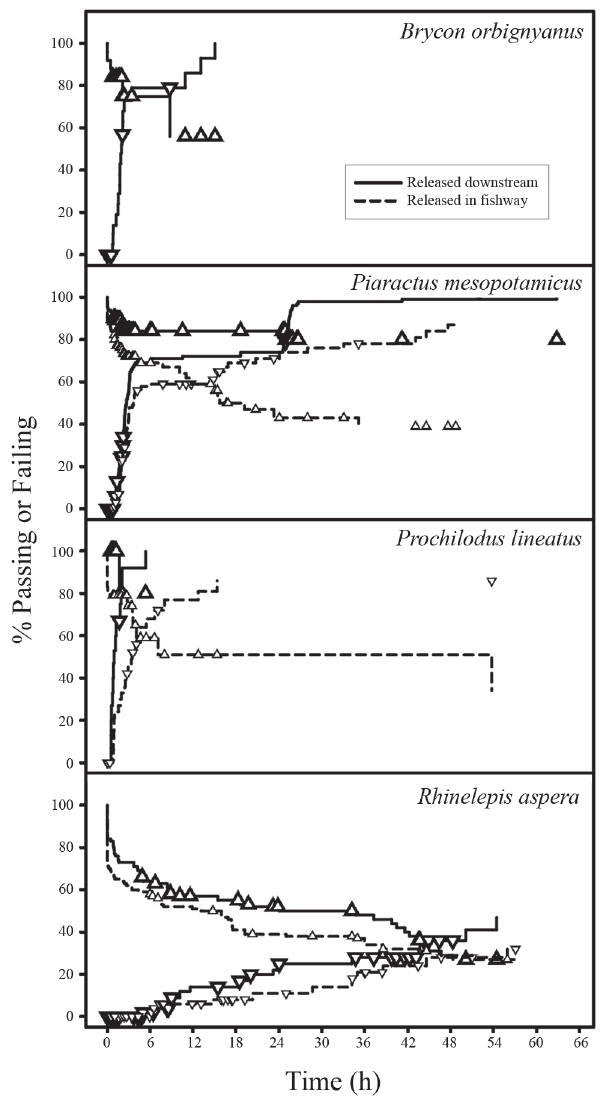
Fig. 7. Cumulative distribution functions (F(t)) and survivorship functions (S(t), calculated using the Kaplan- Meier method, (Kaplan & Meier, 1958)) for 4 species ascending the Porto Primavera fishway, separated by release site. These functions describe the competing risks of fishway passage and fishway failure, quantified in terms of time to pass (F(t) curves, increasing functions) or fail (S(t) curves, decreasing functions). Triangles indicate censored observations, i.e . fish that failed to pass (downward pointing) or succeeded (upward pointing). Failure connotes censoring for passage time estimates and passage connotes censoring for failure time estimates. Only the first 66 h of data are